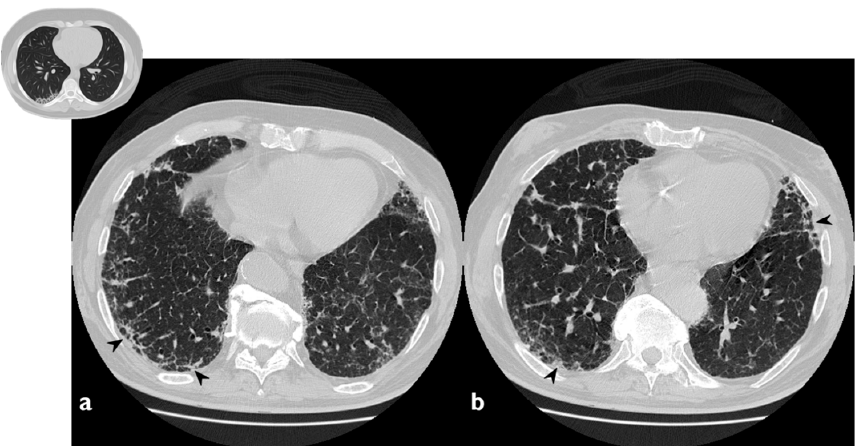
Figure 5. Fibrotic pattern: bilateral sub-pleural reticulations (arrowheads) and architectural distortion, clearly visible in peripheral regions of right lung ( a ) and left lung ( b ).